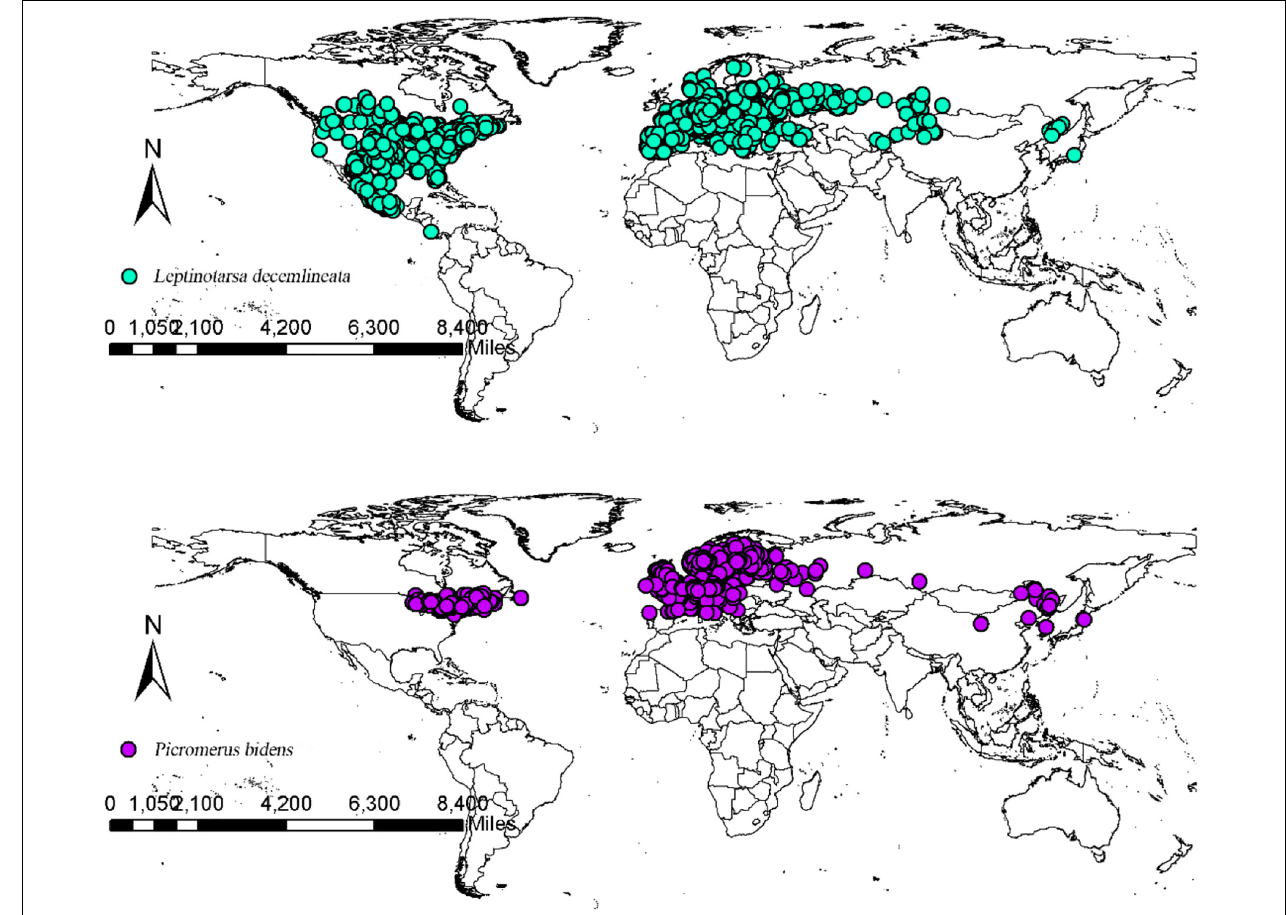
FIGURE 1 | Worldwide geographic distribution records of CPB and P. bidens